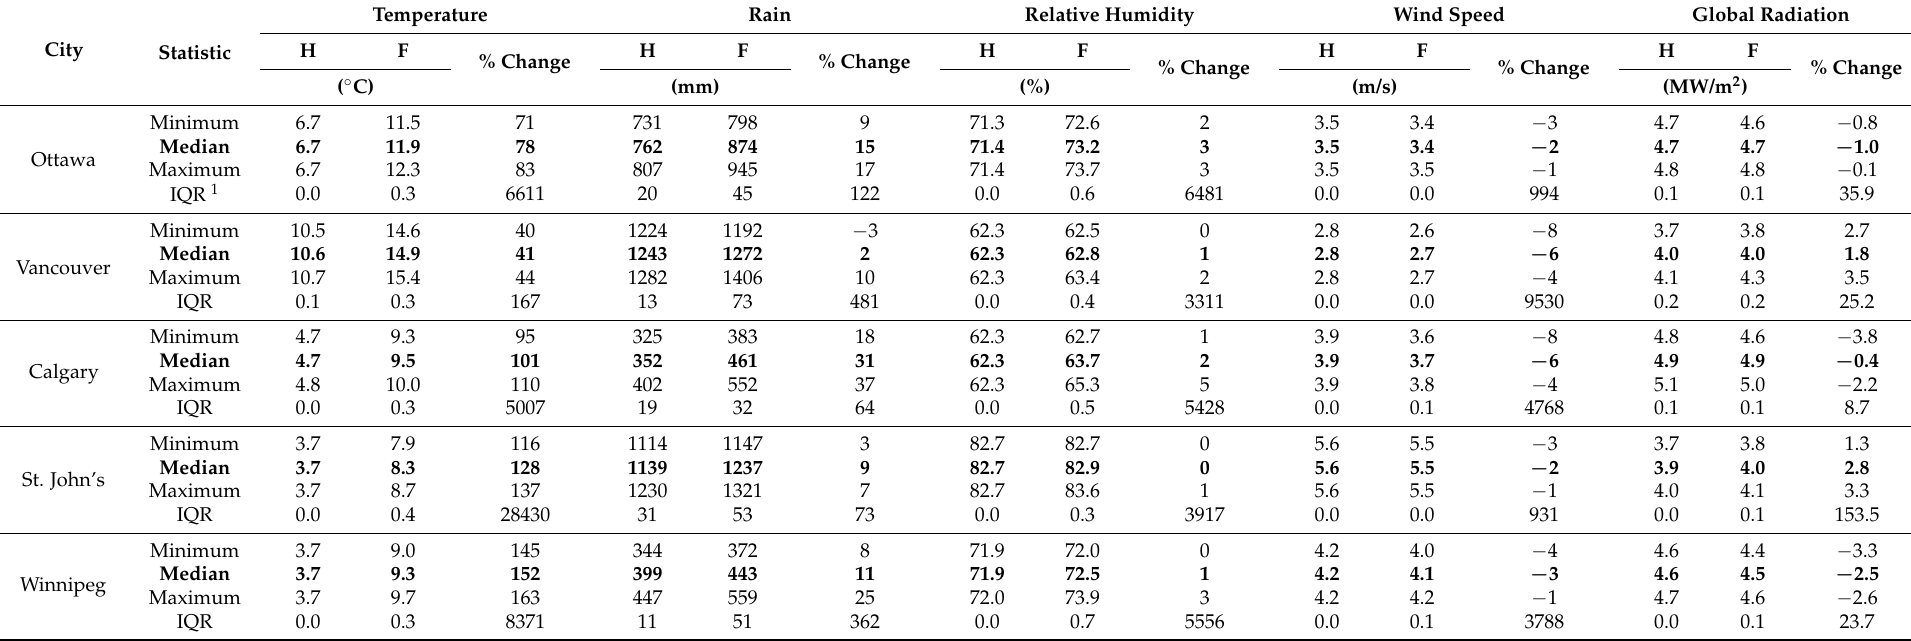
Table 2. Projected changes of some of the climate variables under a global warming scenario of 3.5 ◦ C (F: 2062–2092) in comparison with the reference period (H: